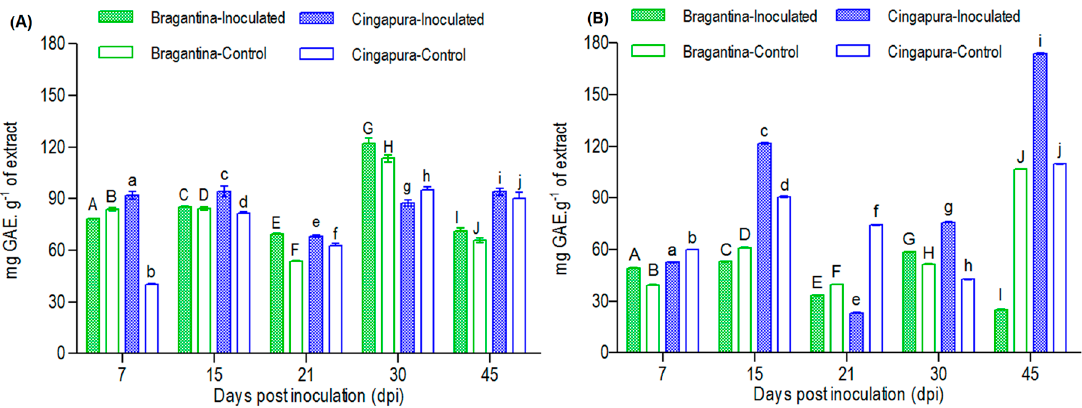
Figure 3. Phenolic content variation in P. nigrum cultivars during infection by F. solani f. sp. piperis